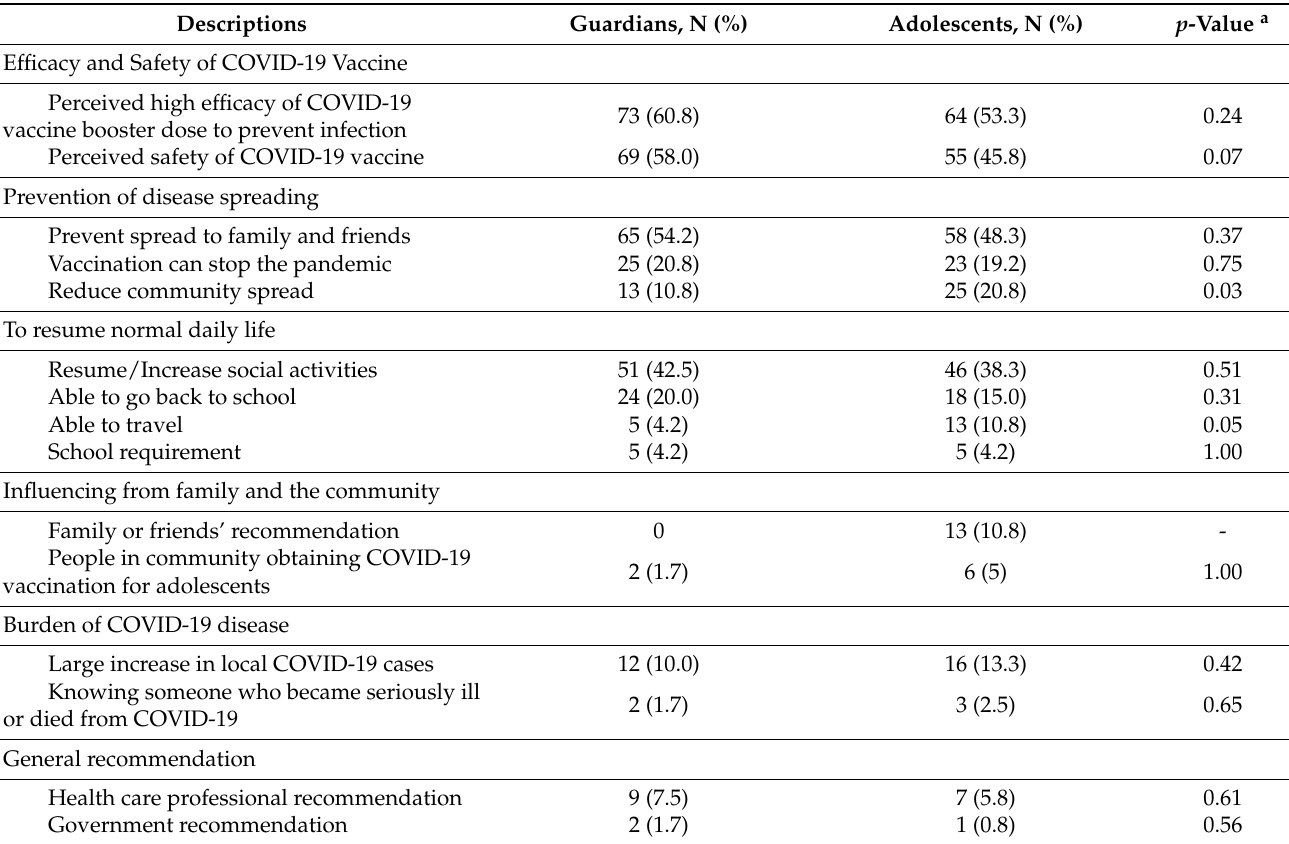
Table 4. Top three reasons underlying intention to receive the BNT162b2 booster dose in guardians and